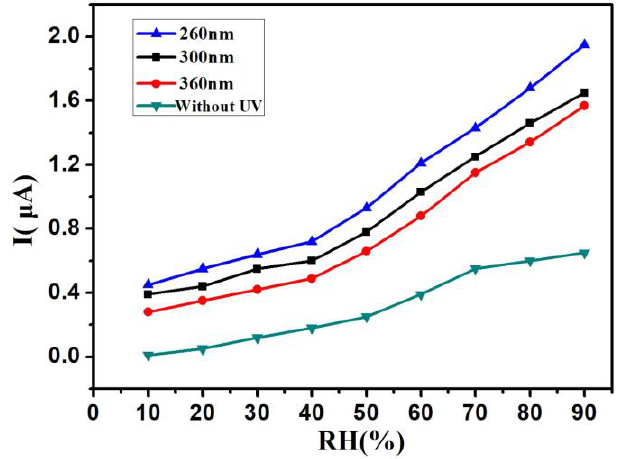
Figure 4. The current (I)-relative humidity (RH) curves at an applied voltage of 1 V with different UV wavelengths from 260 nm to 360 nm with the same power, 150 μW, and without UV irradiation.